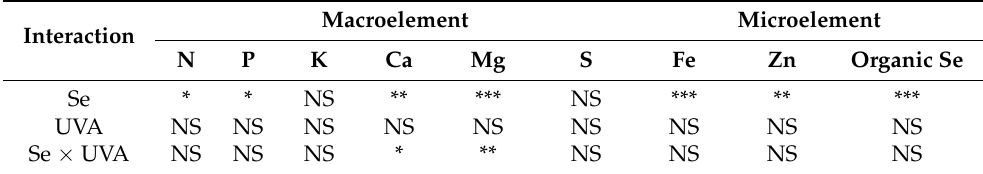
Table 6. The interaction effects of Se and UVA on mineral elements content of broccoli microgreens. Macroelement Microelement Interaction N P K Ca Mg S Fe Zn Organic Se Se NS NS UVA NS NS NS NS NS NS NS NS NS Se × UVA NS NS NS NS NS NS, *, **, and *** represent nonsignificant or significant at p < 0.05, 0.01, and 0.001, respectively, according to two-way ANOVA.